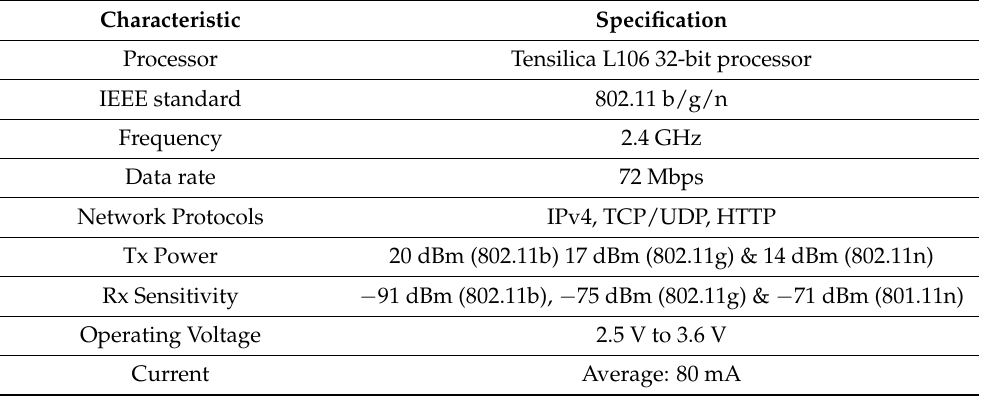
Table 4. Technical specifications of ESP 8266